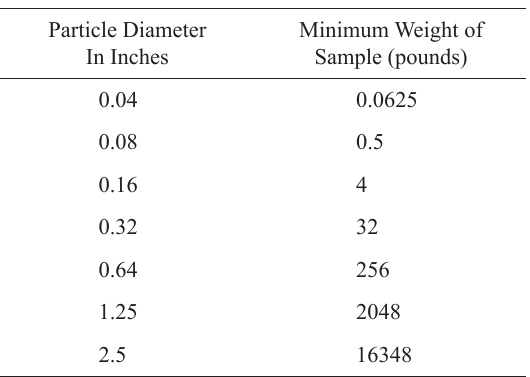
Table 1 Minimum Weight of Samples as a Function of Particle